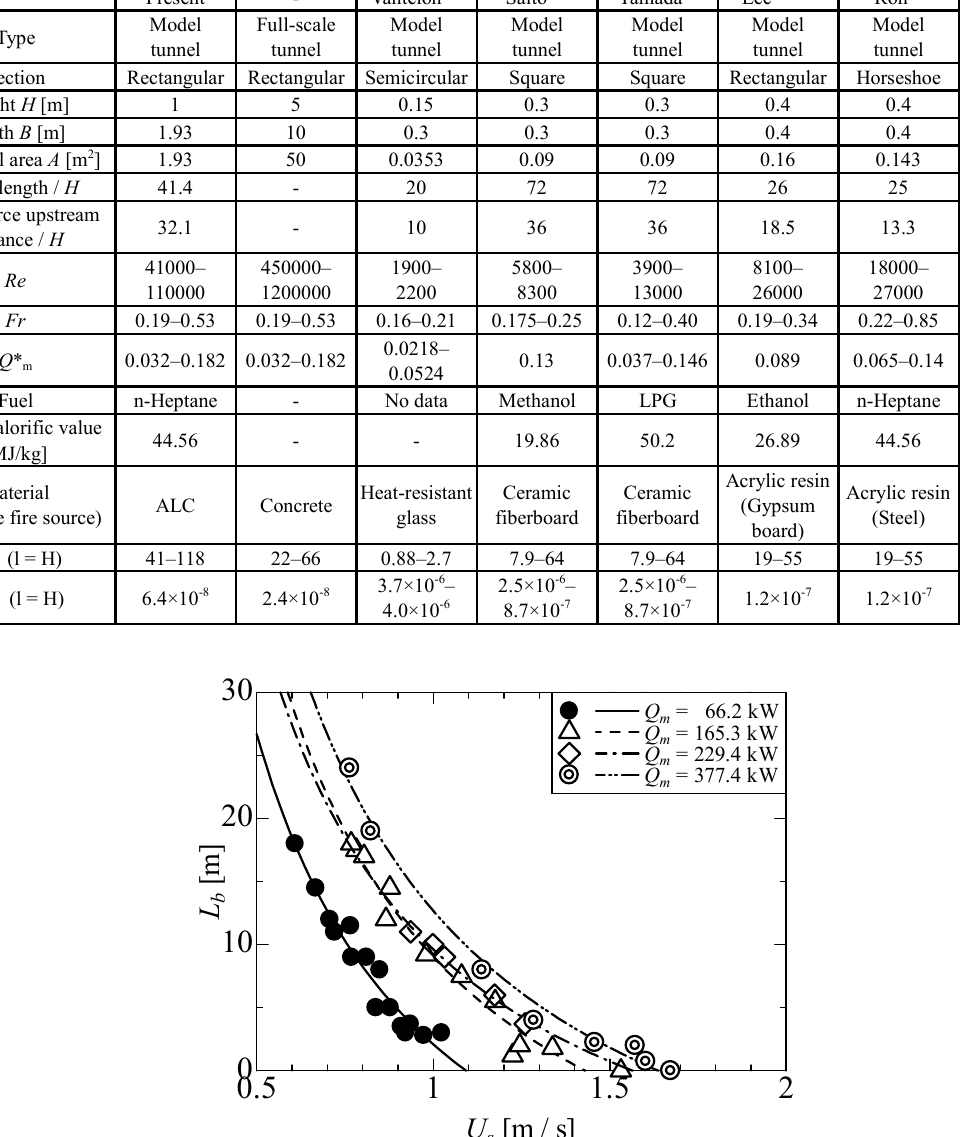
Fig. 6 Relationship between the average longitudinal velocity U s and the backlayering distance L b in four cases of average heat release rate Q m . The symbols indicate the following: black circles, 66.2 kW; white triangles, 165.3 kW; white diamonds, 229.4 kW; double circles, 377.4 kW. The solid line, dashed line, chained line, and double-dashed chained line were drawn by using Eq. (1), respectively. The constants of Eq. (1) were calculated from the experimental data, using the least squares